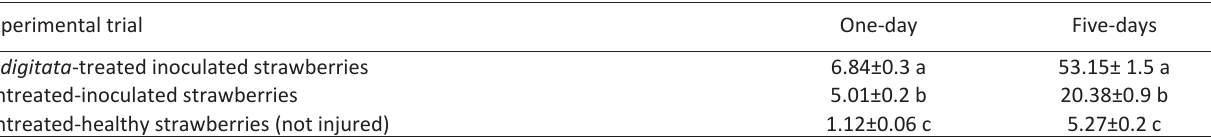
Values are the pooled mean±SD of three replicates of 10 fruit for each analyzed by one-way ANOVA. In each column, values followed by different letters are significantly different according to Duncan Multiple Test Range (DMRT) at a probability P≤0.05 level. Change in absorbance on the fresh weight basis (Δ OD420 g -1 min -1